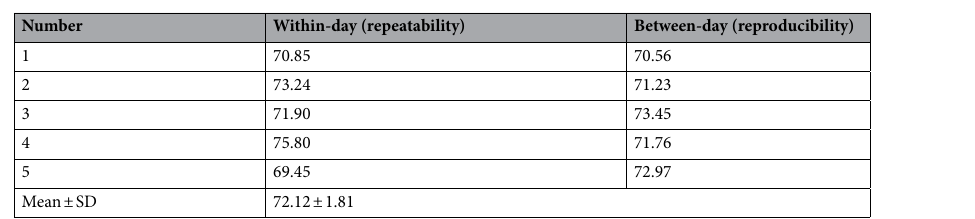
Table 7. Data of the precision for the adsorption of MG dye onto meso-CaAl 2 O 4 in the textile wastewater (volume = 50 mL, initial dye concentration = 50 mg L −1 , adsorbent mass = 15 mg, contact time = 15 min, T = 25 °C, pH